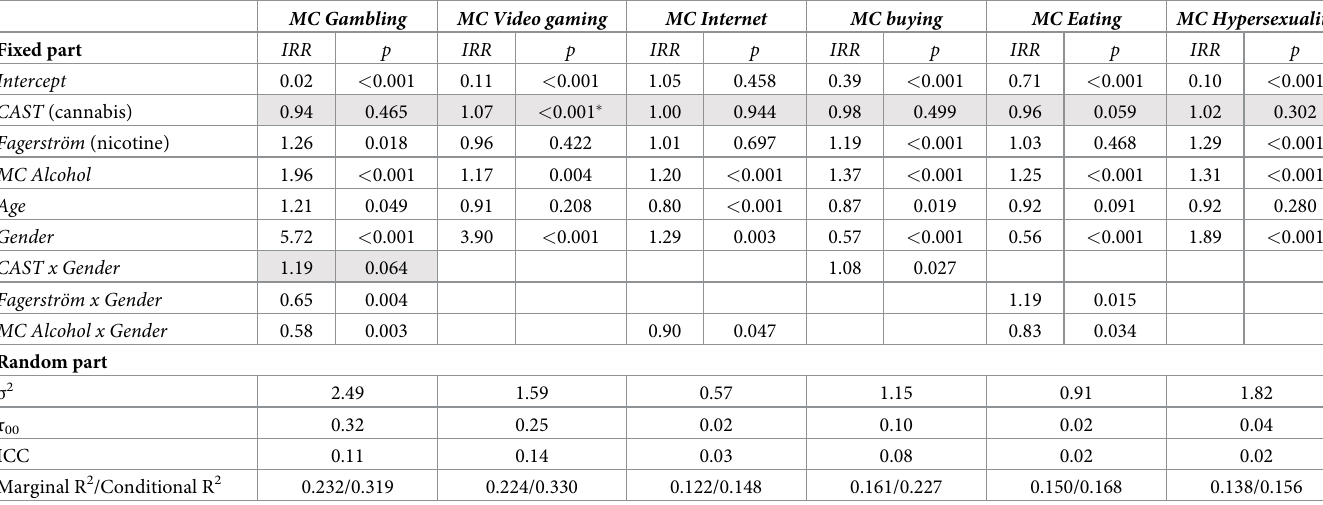
Table 3. Mixed-effect regressions for non-substance MultiCAGE dysregulated behavior scores over CAST cannabis score and relevant